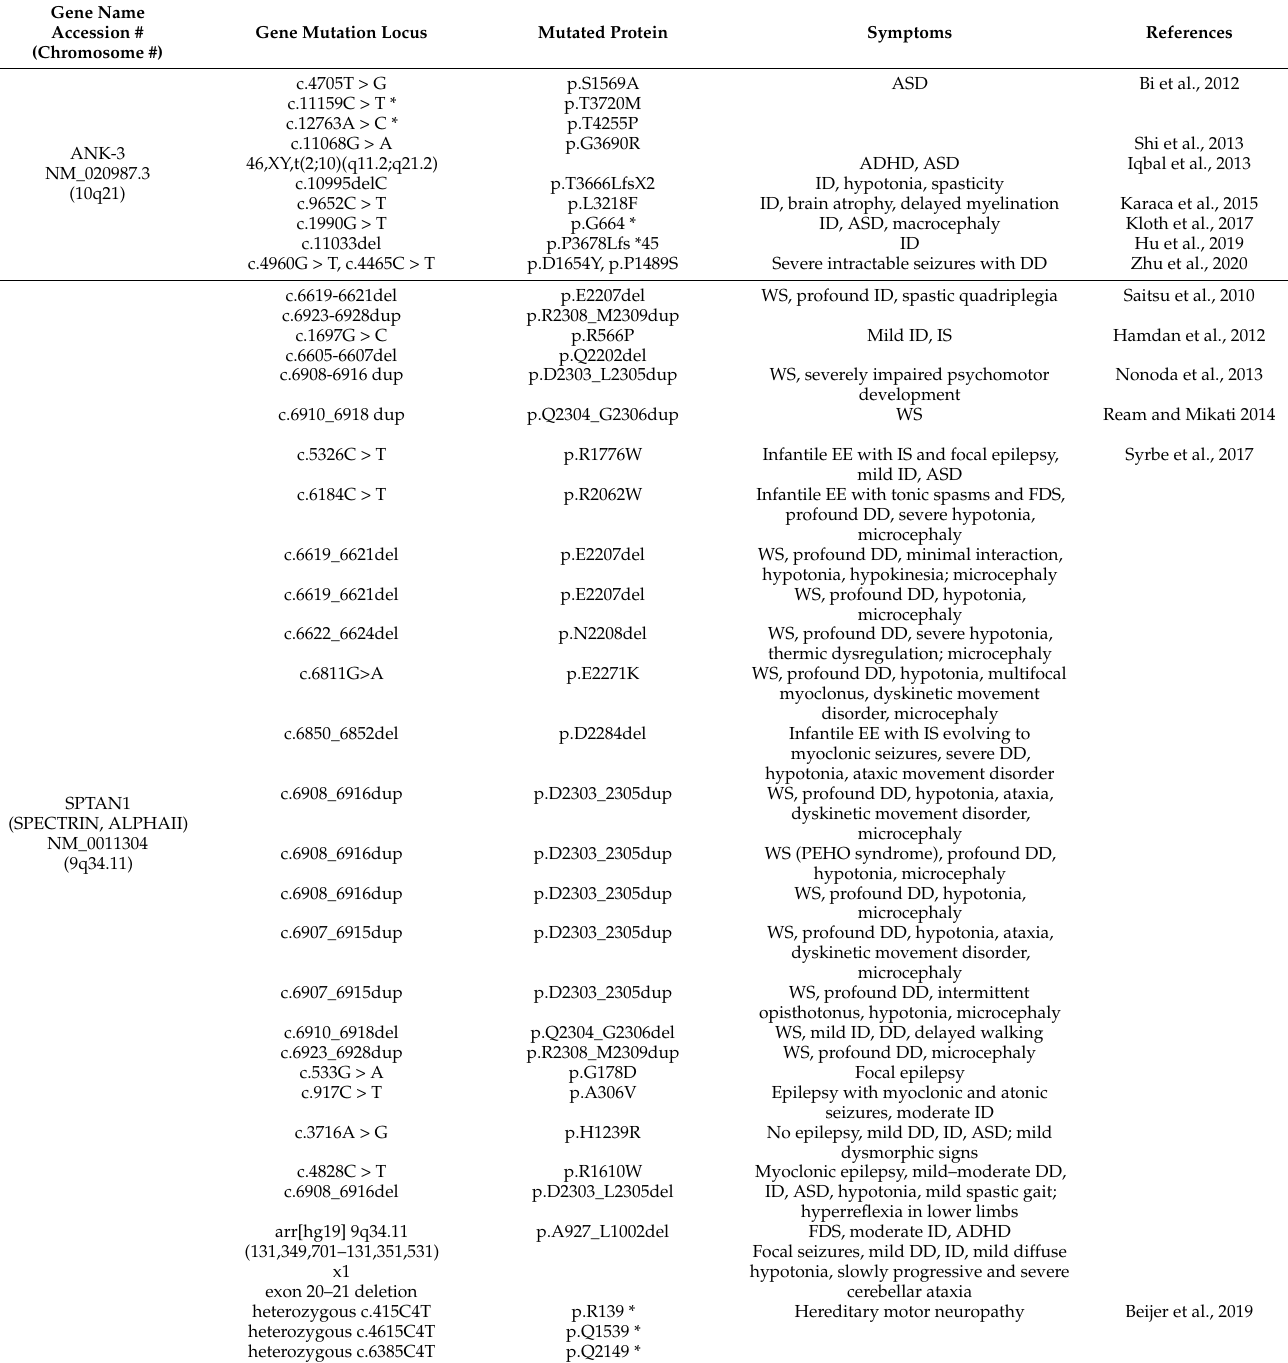
Table 1. Mutations of ANK-3 , SPTAN1 , SPTBN4 , and related